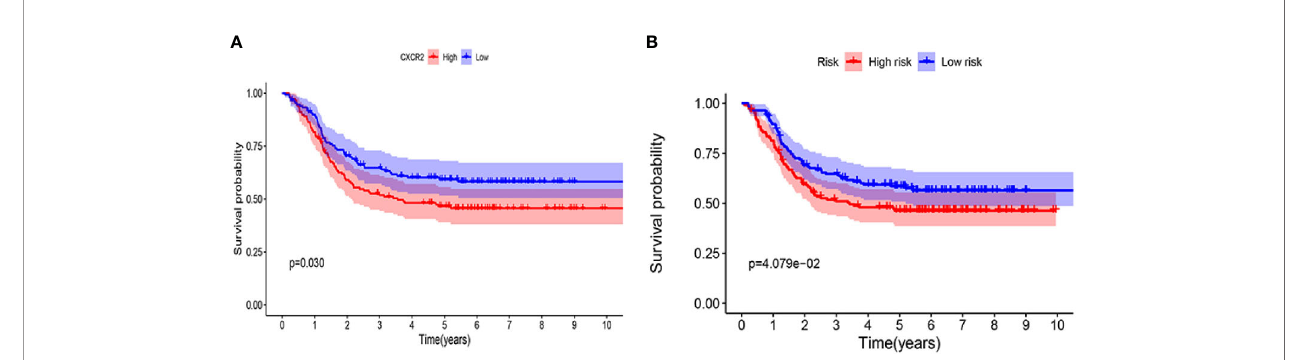
FIGURE 11 | Kaplan-Meier survival curves in validation cohort using TARGET database. (A) CXCR2. (B) CXCR